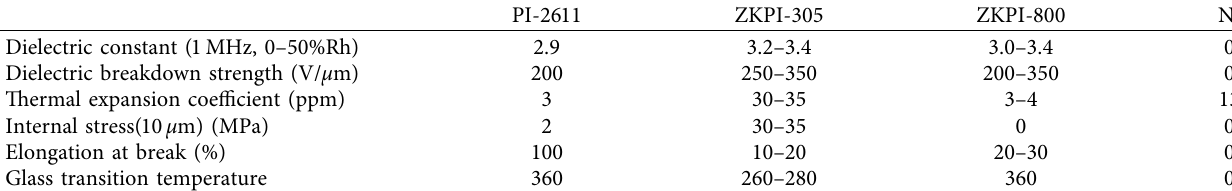
Table 3: The imidization parameters of polyamic acid.